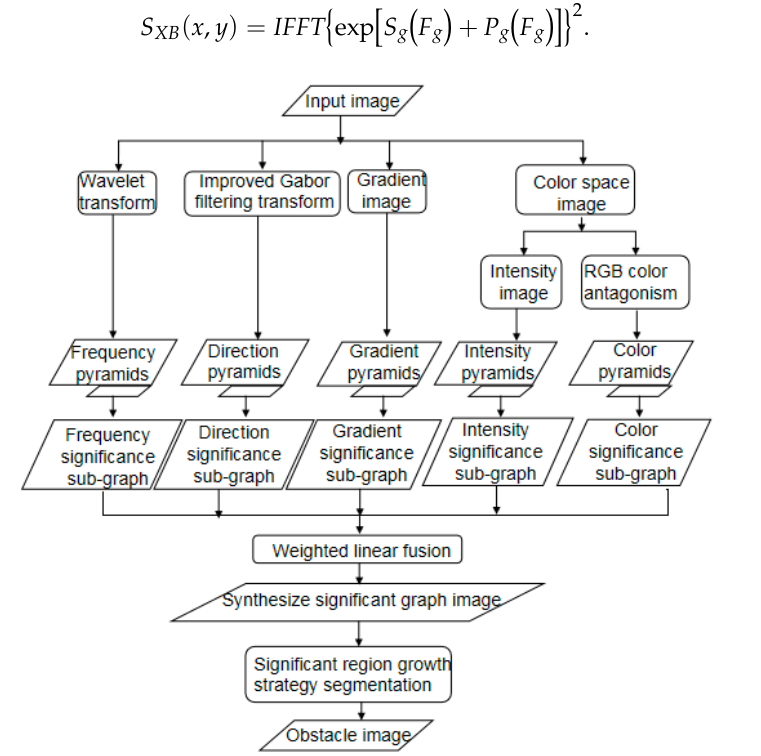
Figure 2. Process flow of the saliency detection model for multi-visual feature fusion.